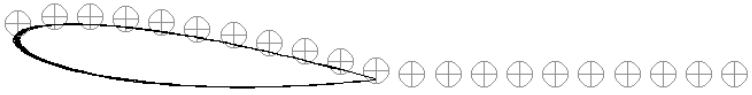
Figure 2. Monitor points.